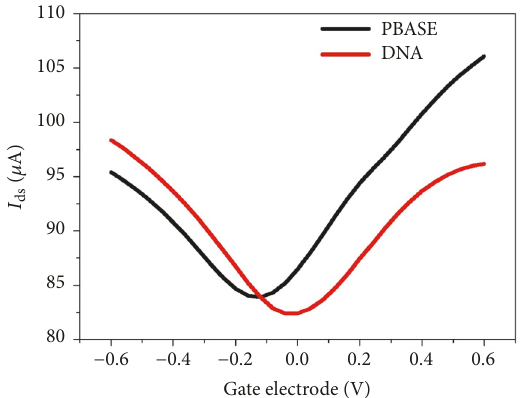
Figure 3: The transfer characteristics of the PBASE modified G-FET (black curve) and after probe DNA functionalization (red